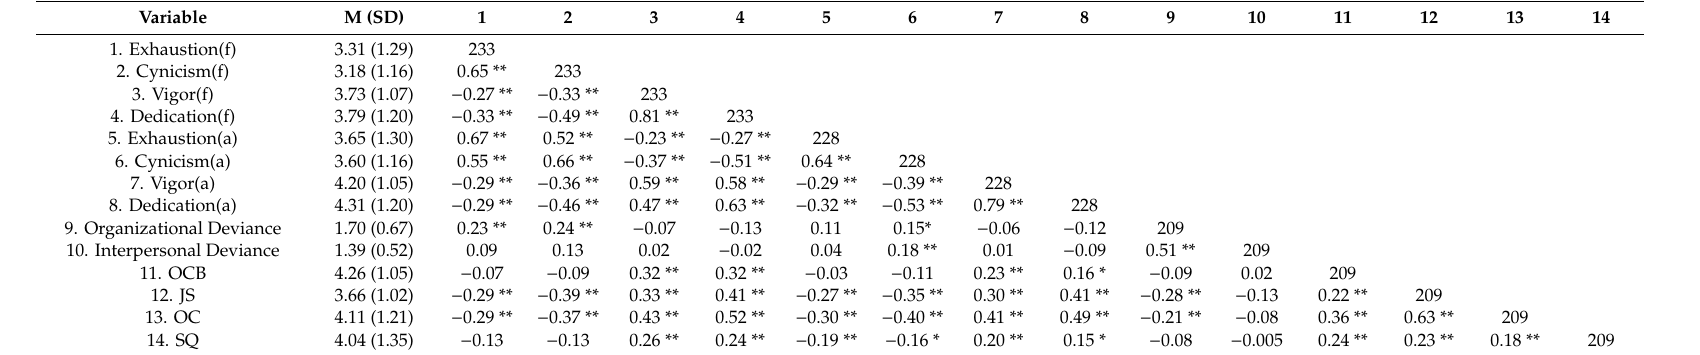
Table 2. Mean, standard deviation, and correlation matrix for Sample 1 ( N =